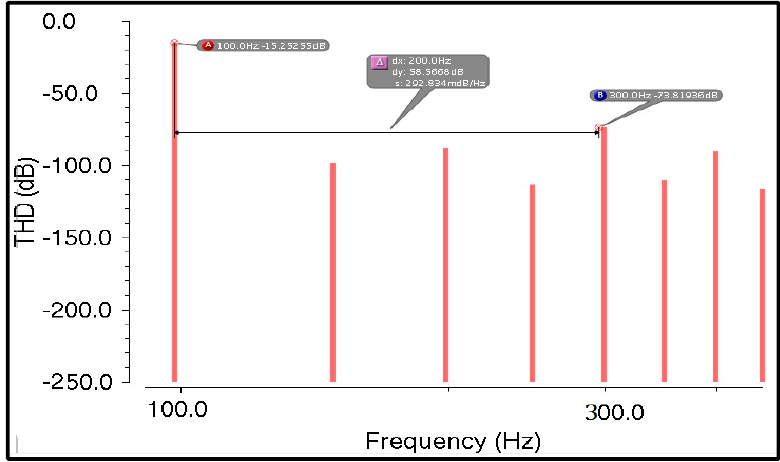
Figure 17. Total harmonic distortion (THD) plot, applying a sinusoidal input of 200 mVpp at a frequency of 100 Hz.